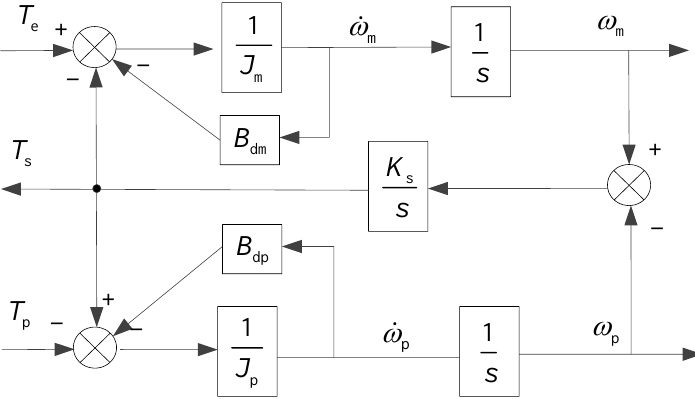
Figure 13. Block diagram of rotor shaft system transfer function.